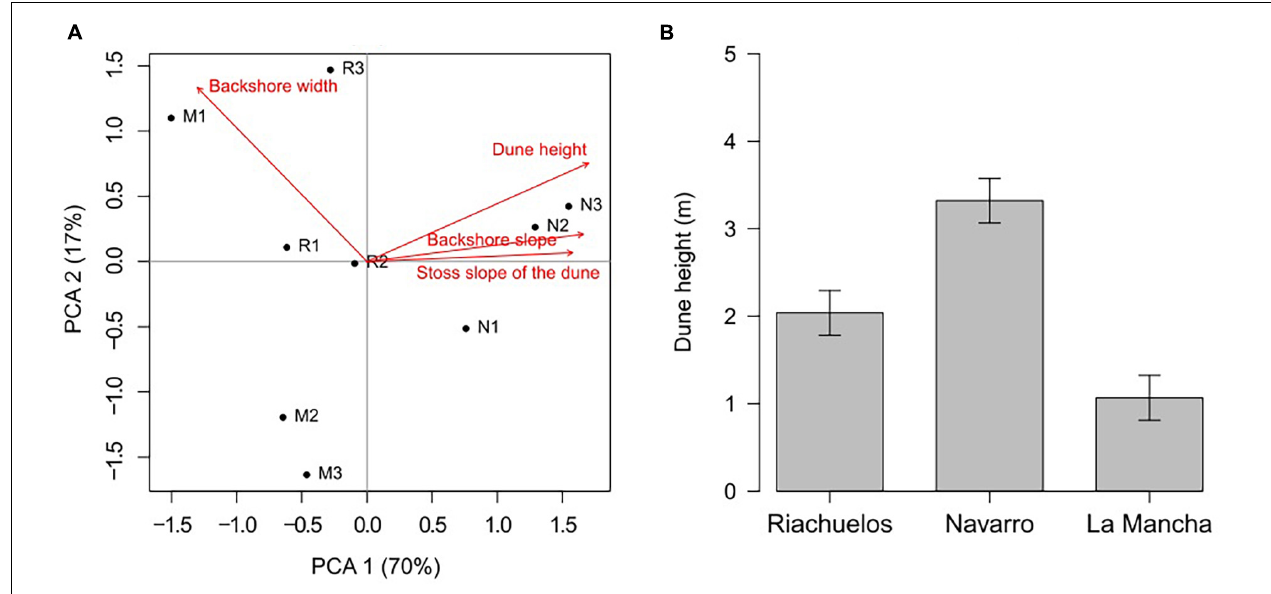
FIGURE 10 | (A) Geomorphological variables included in the Principal Component Analyses. (B) Mean height of the frontal dunes on the three beaches (incipient dunes for Riachuelos and La Mancha, and foredunes at Navarro).